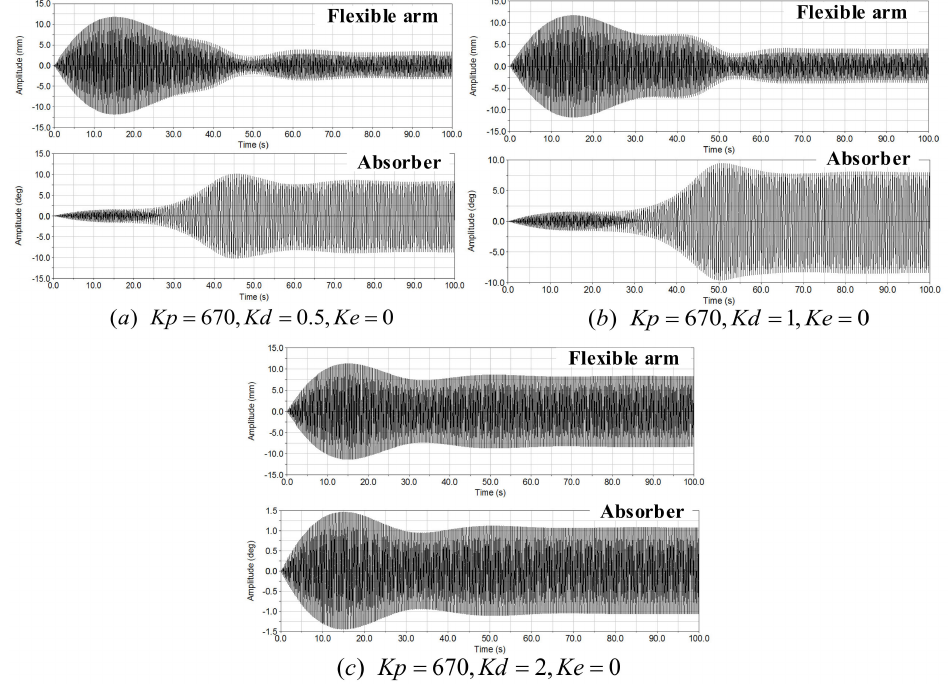
Figure 12. Effect of Kd on saturation amplitude of the flexible manipulator and vibration